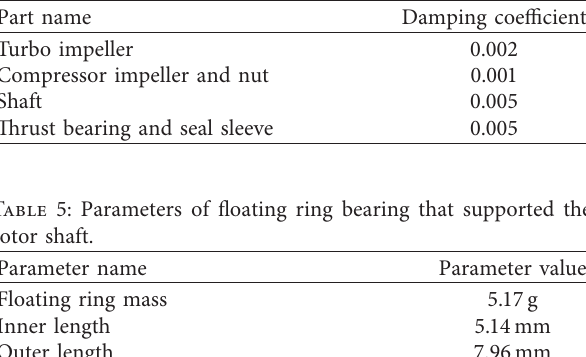
Figure 5: Material properties of rotor-shaft system as a function of temperature (Young’s modulus, Poisson ratio, specific heat capacity, and thermal conductivity). (a) K418. (b) ZL105. (c) 42CrMo. (d) 316 stainless steel [25, 26]. Table 4: Damping coefficient of each part.